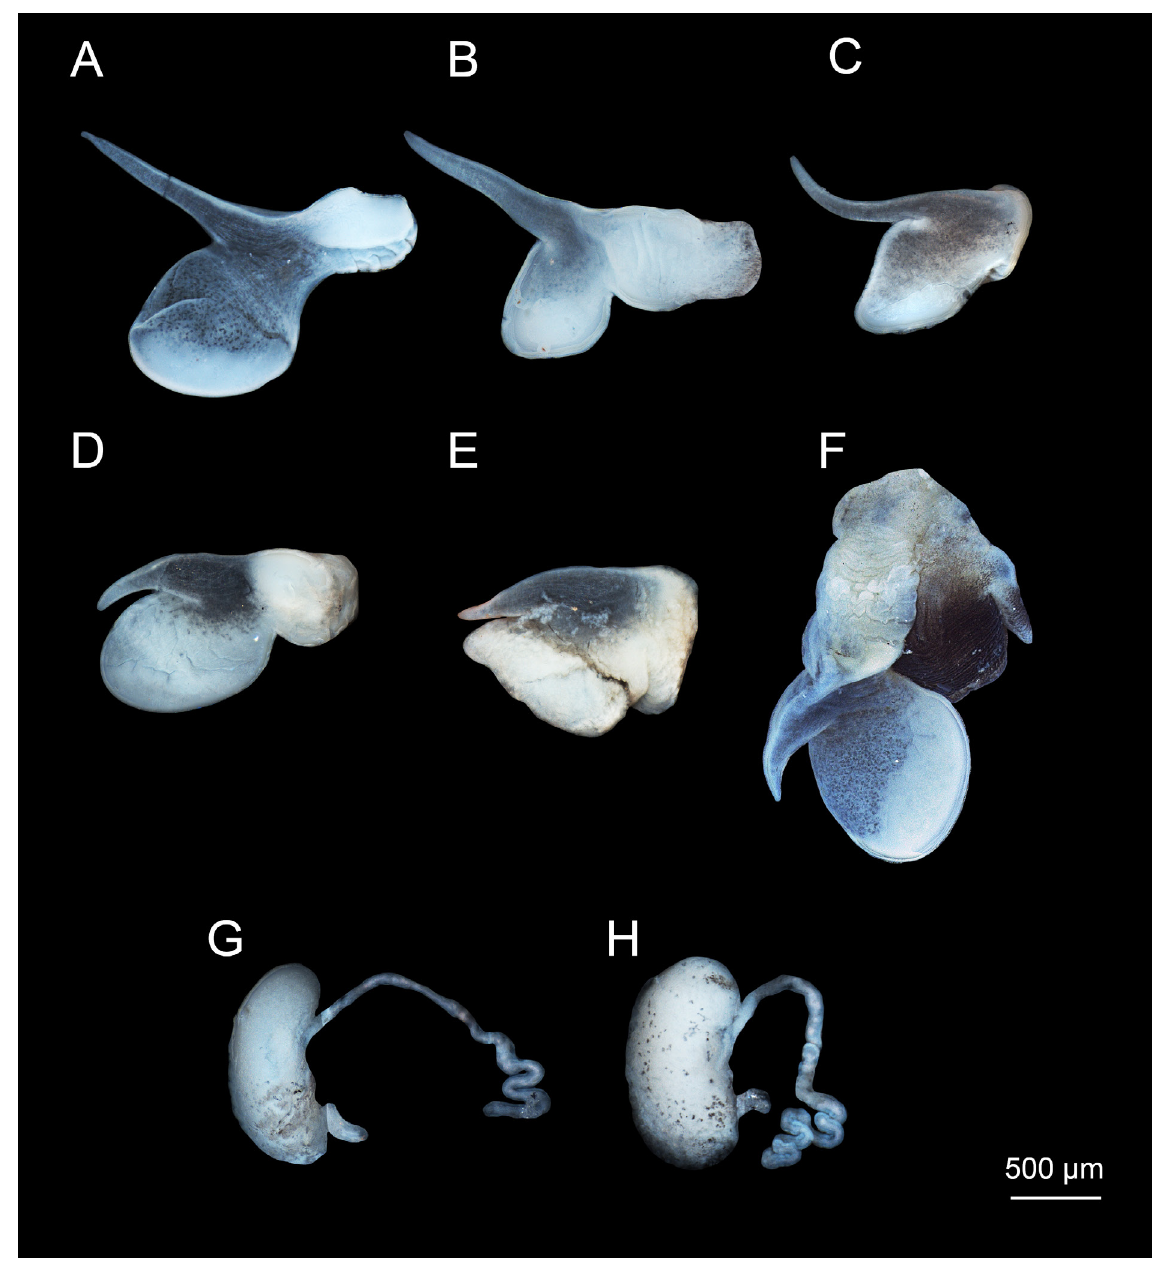
Fig. 7. Male genitalia of Mercuria similis (Draparnaud, 1805). A–E . Penis. F . Penis and